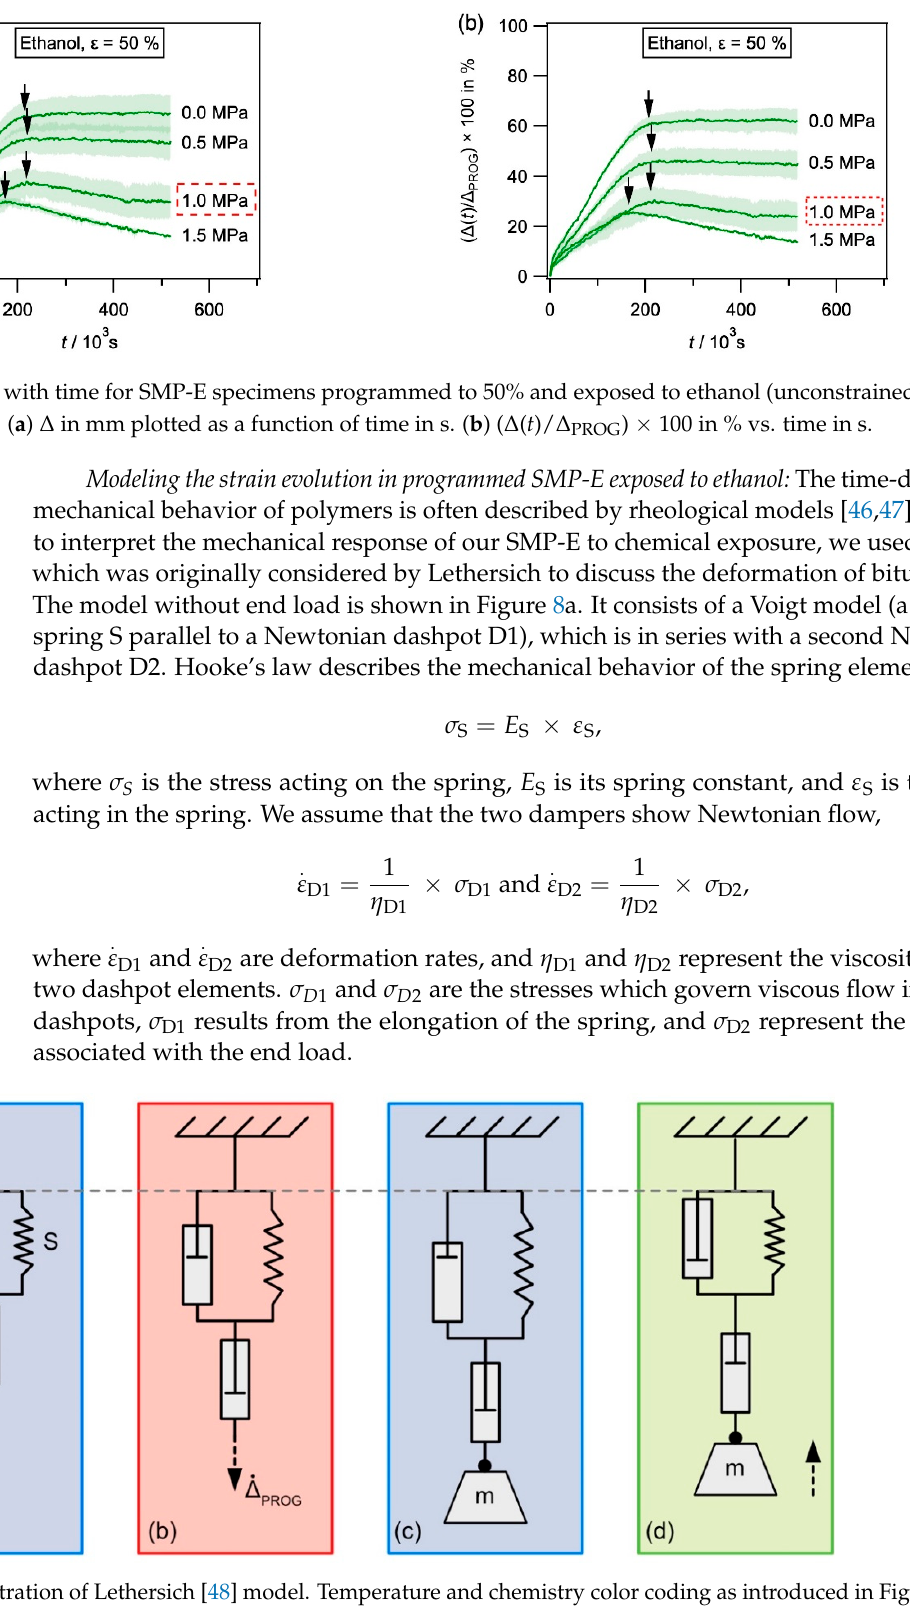
. ∆ PROG in mechanical test rig